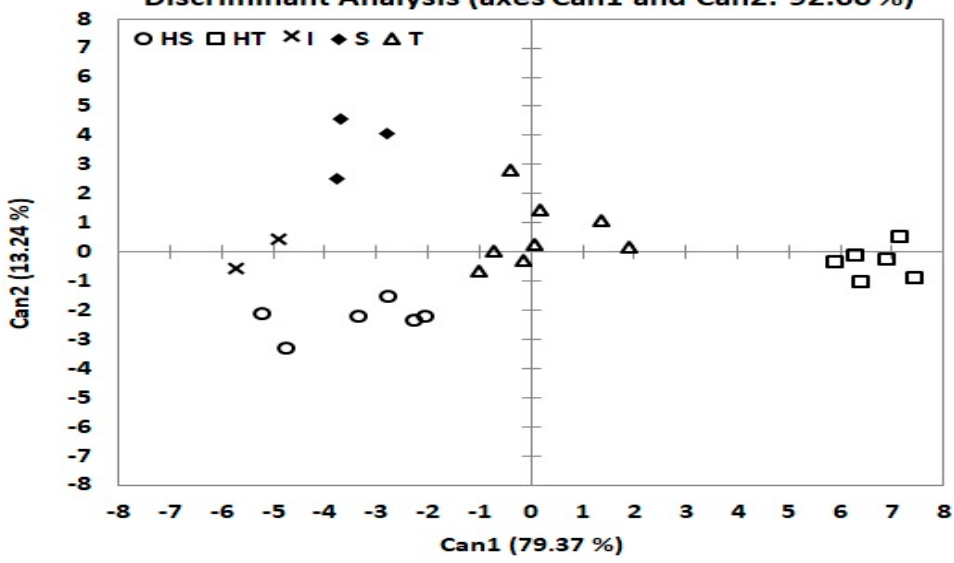
Figure 4. Distribution of 25 wheat genotypes by canonical discriminant analysis (Can) of relative water content, canopy temperature, leaf area index and green leaves area traits responses to drought stress. Highly tolerant (HT), tolerant (T), intermediate (I), sensitive (S) and highly sensitive (HS).